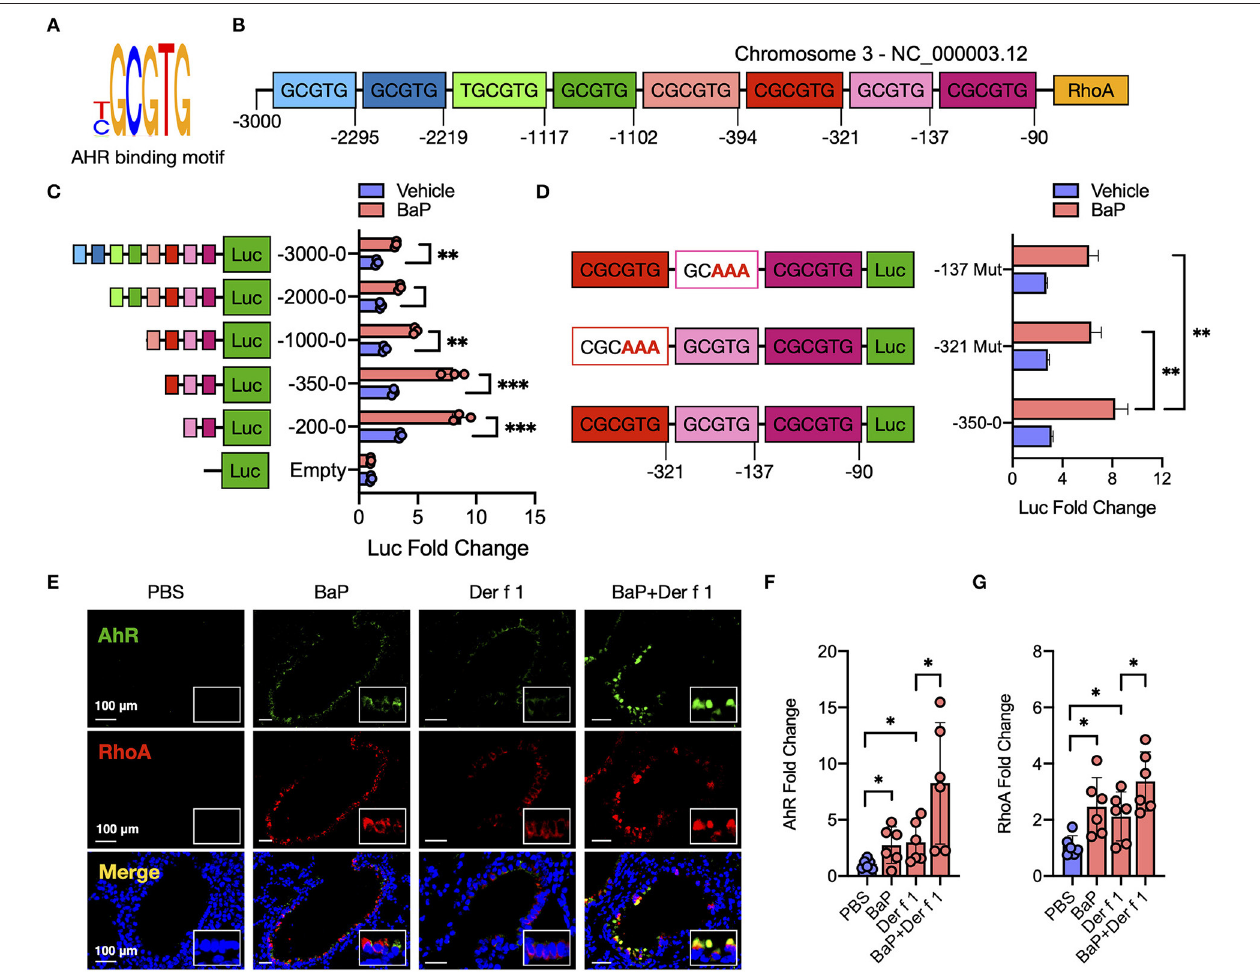
FIGURE 5 | AhR directly binds RhoA and participates in the BaP-induced RhoA activity. (A) Sequence of AhR binding site. (B) Eight putative AhR binding sites in the promoter region of RhoA. (C) Luciferase reporter assays with luciferase reporter vector pGL-3 basic (empty) or containing serially truncated fragments of the RhoA promoter (AhR reporter) in 16HBECs. (D) Luciferase reporter assays with luciferase reporter vector pGL-3 basic containing wild-type or mutated truncated fragments in 16HBECs. (E) Representative immunofluorescence images of AhR, RhoA, and co-localized expression in the lung tissues of a mouse model. (F,G) Quantitative analysis of the fluorescent signal in (E) ( n = 6 mice/group). Fluorescent-positive cells of tissue sections for AhR (F) and RhoA (G) were quantified in at least four different high-power fields (500 µ m 2 ) in two to three different lung sections per mouse by using Fiji ImageJ. Data represent mean ± SEM. * p < 0.05, ** p < 0.01, and *** p <